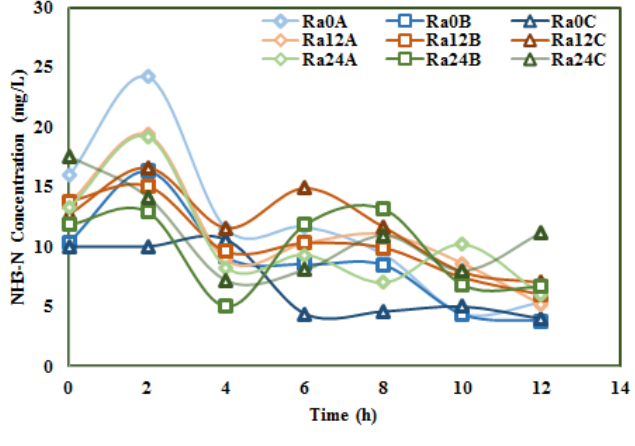
Figure 3. Measured NH3-N concentration at specified time for each reactor